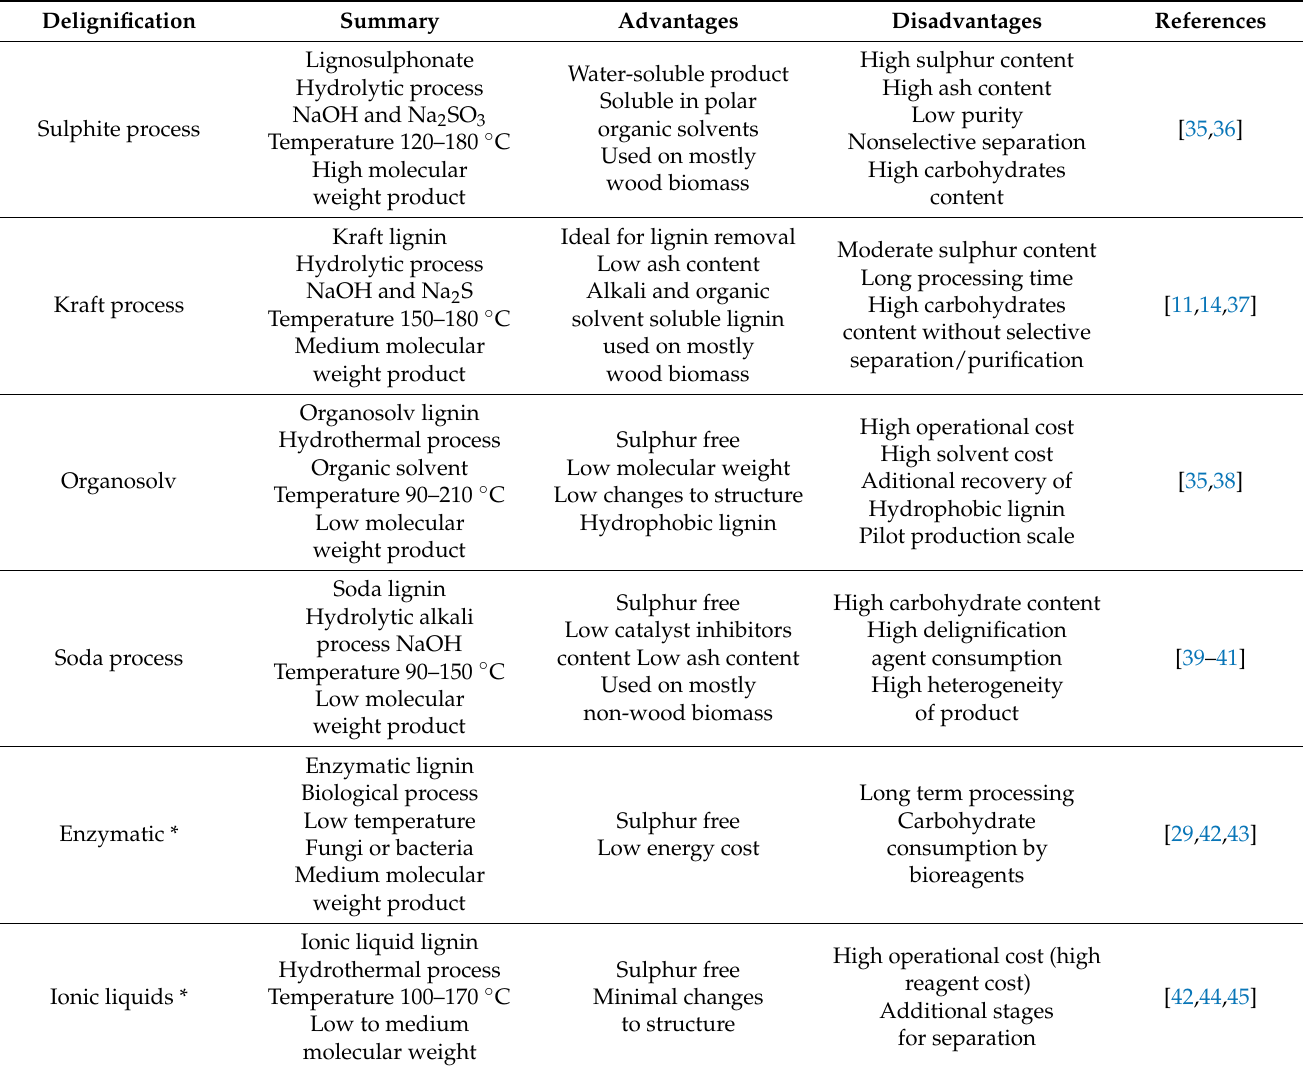
Table 1. Brief overview of lignin isolation